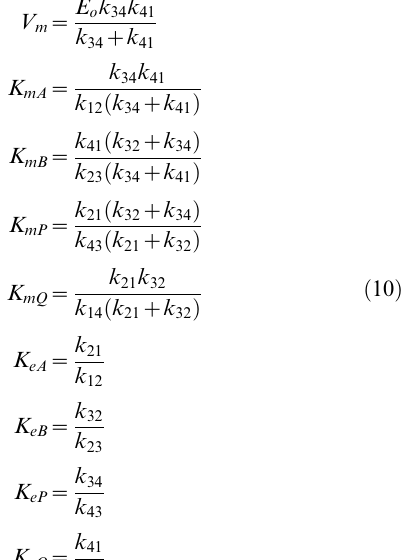
Table 1. The biochemical reaction, involving biochemical